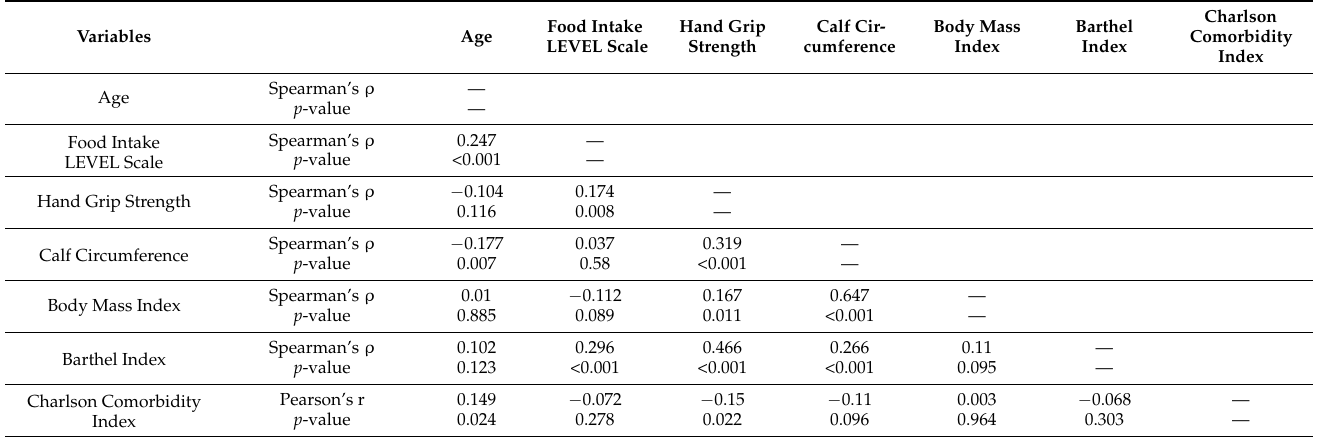
Table 5. Correlation coefficient table for explanatory variables in logistic regression analysis in